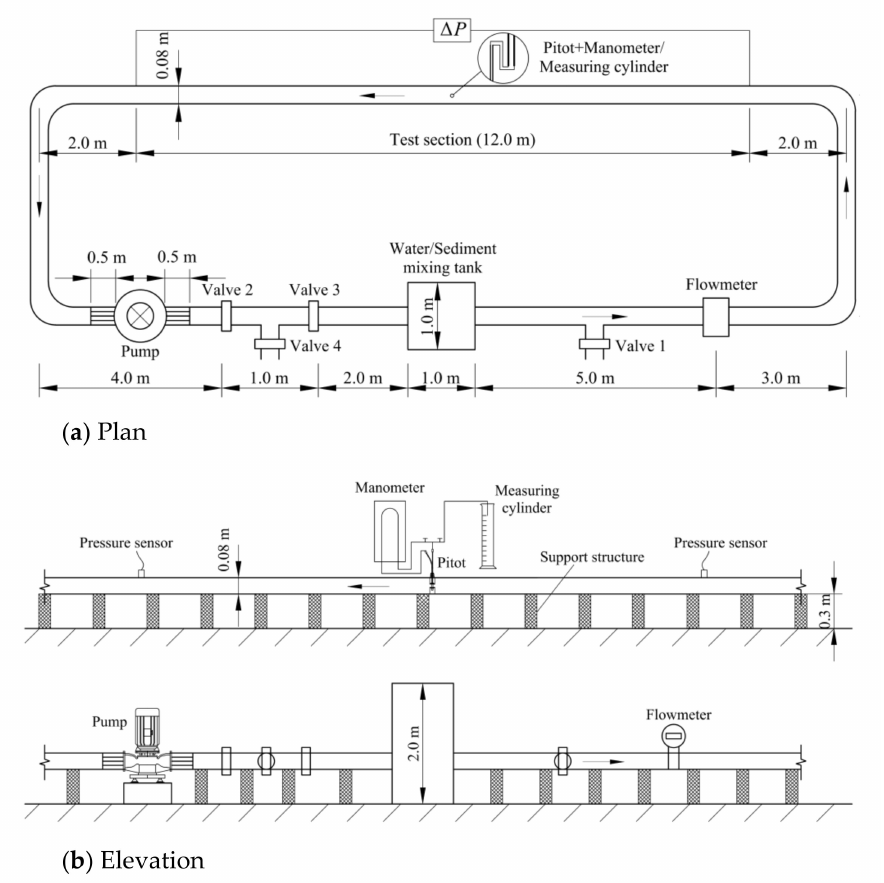
Figure 1. Sketch of the circulating pipe experimental system (not to